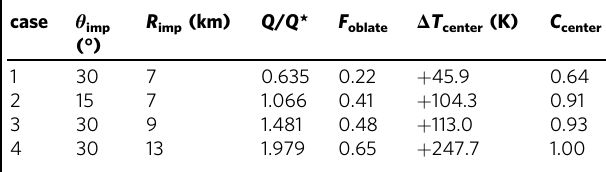
Table 1 Summary of simulation parameters and